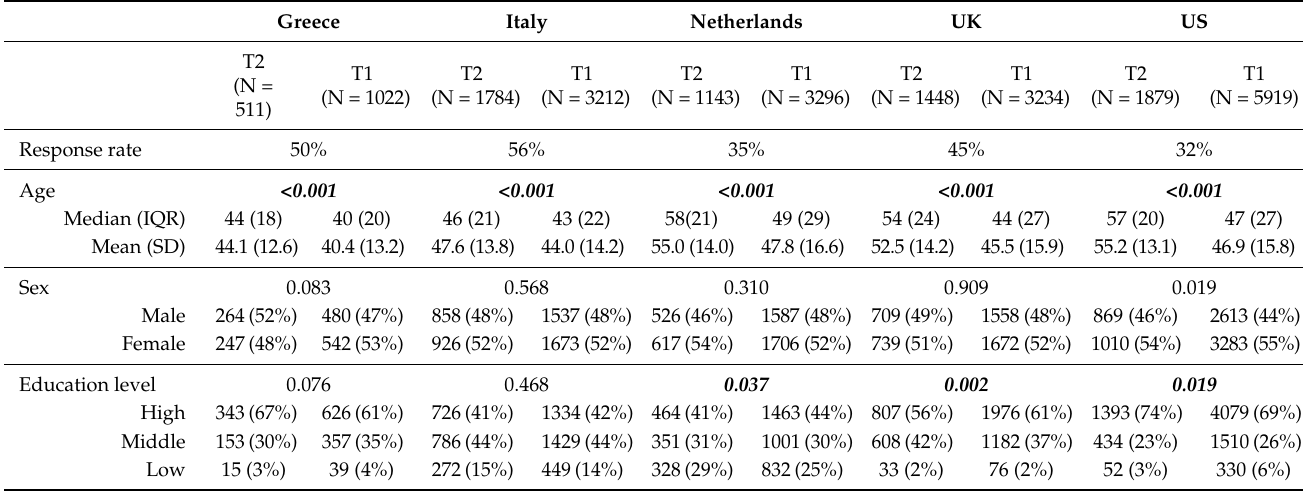
Table A1. Characteristics of respondents at T2 and